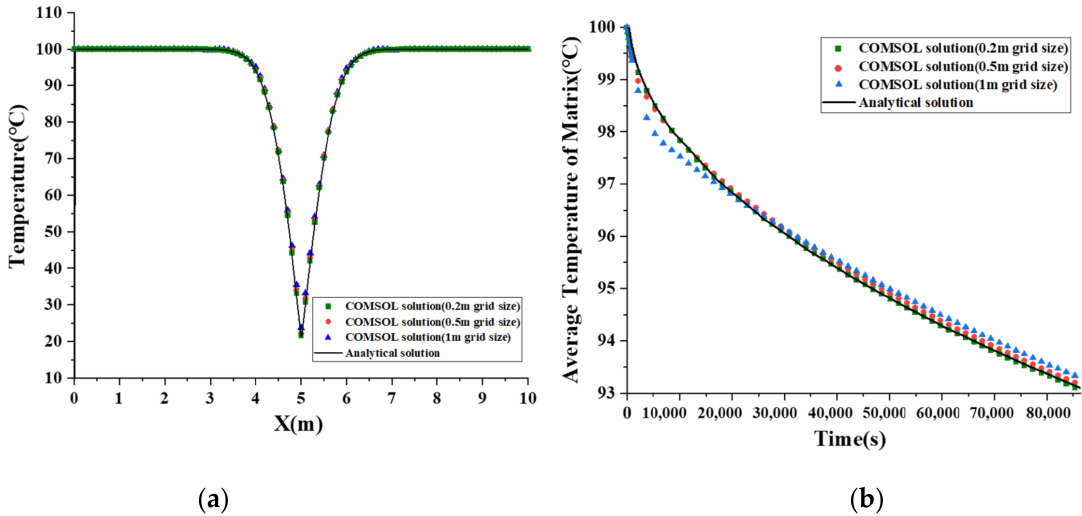
Figure 8. ( a ) Matrix temperature distribution along the x-direction at z = 5 m after 86,400 s injection and ( b ) average temperature of the matrix with time at different grid